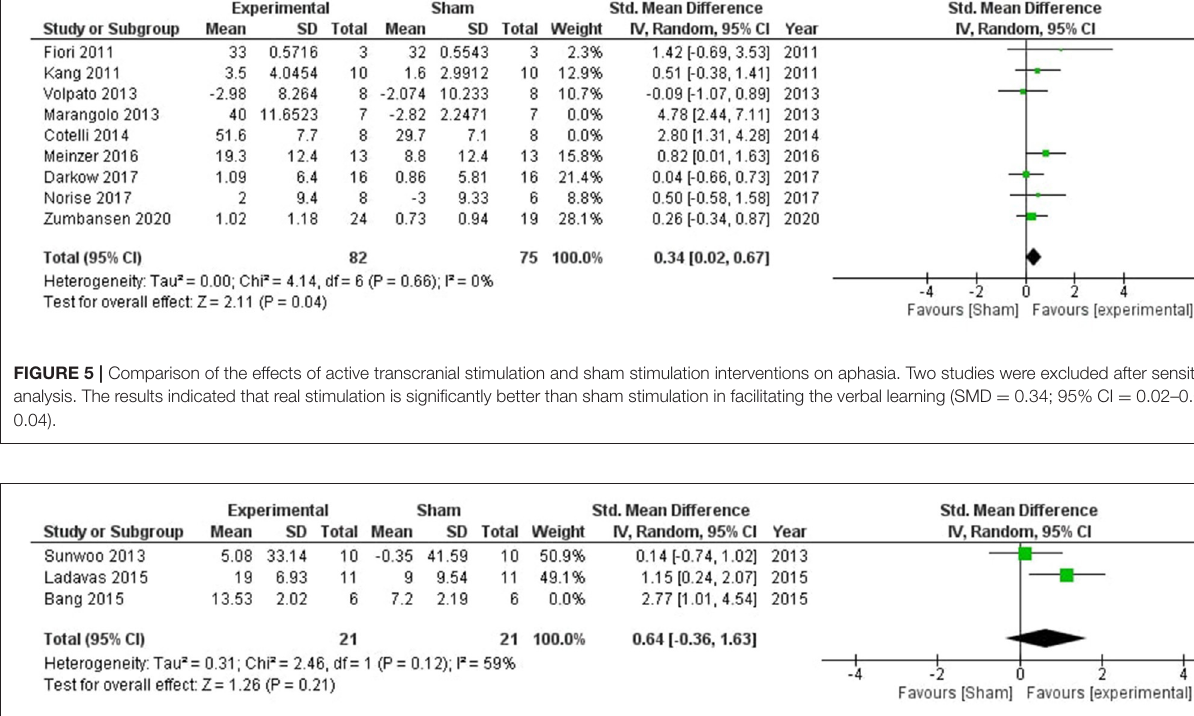
FIGURE 6 | Comparison of the effects of active transcranial stimulation and sham stimulation interventions on visual neglect. One study was excluded after sensitivity analysis. No stimulation related significant effect was observed (SMD = 0.83; 95% CI = − 0.49–2.15; p =